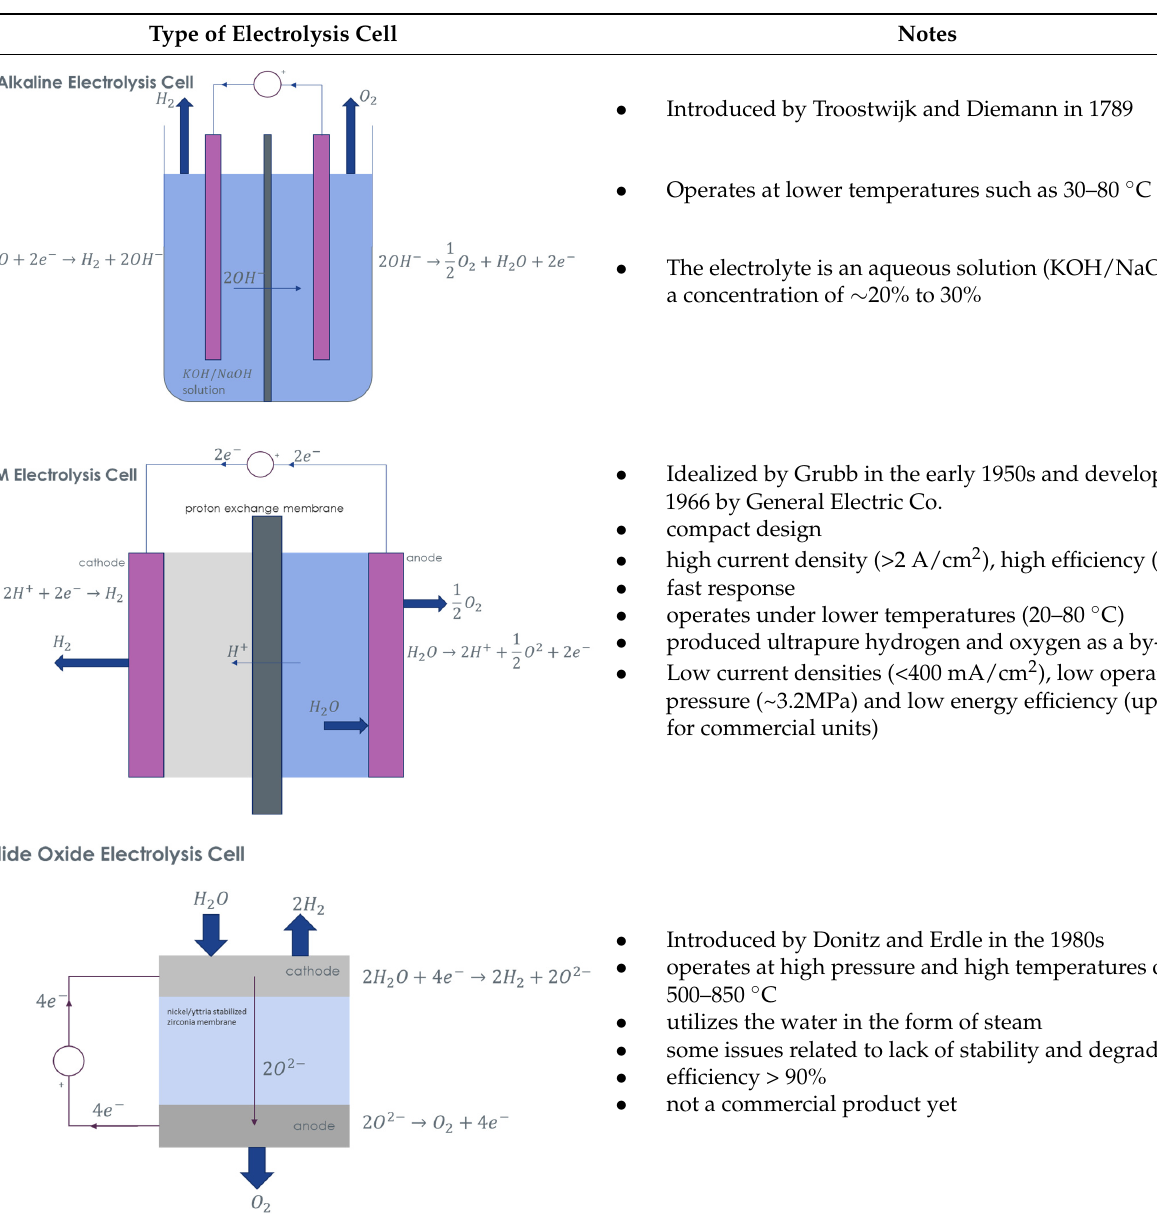
Table 3. Most important electrolyzers technologies.